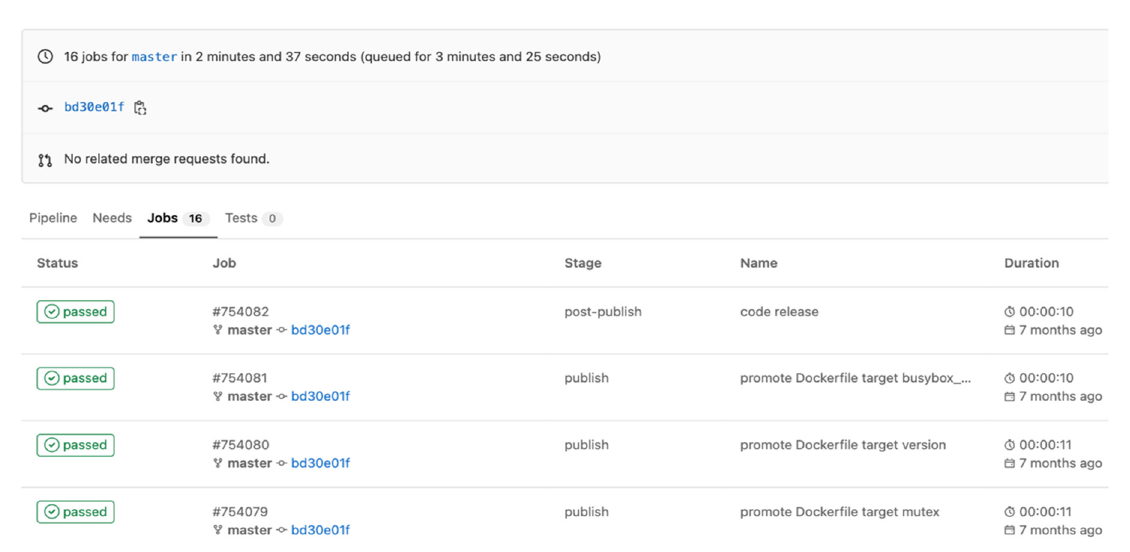
Figure 12. Pipeline steps and duration.